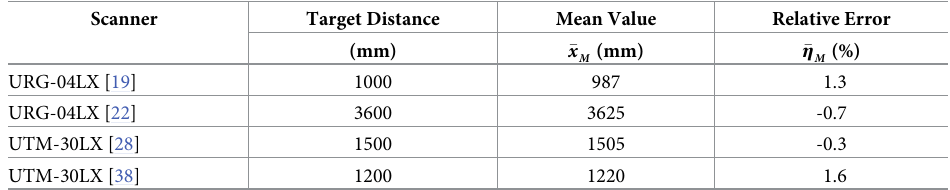
Table 5. Comparison of range measurements.